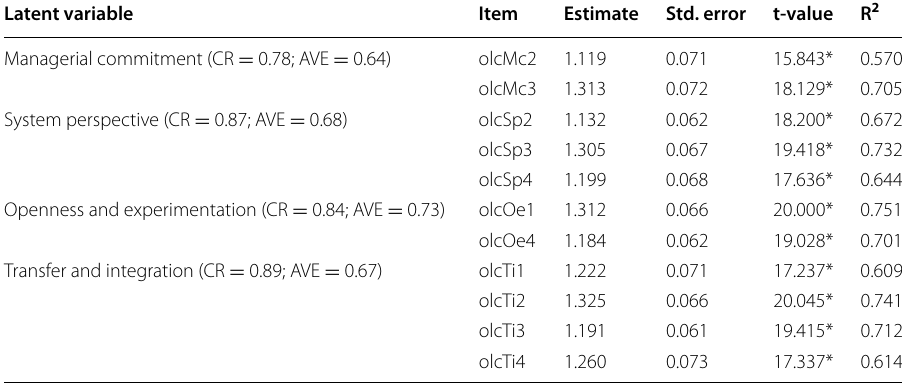
Table 3 Parameters estimates for